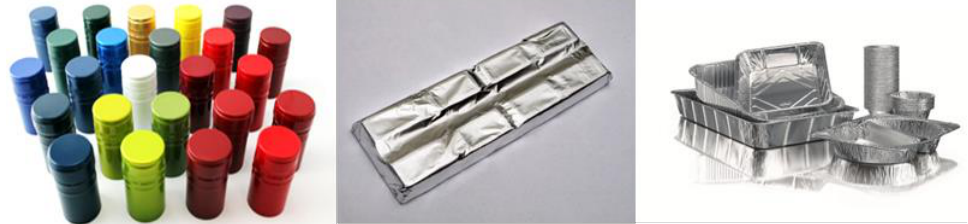
Figure 1. Bottle capsules, flexible and semi-rigid packaging produced using AA8079.